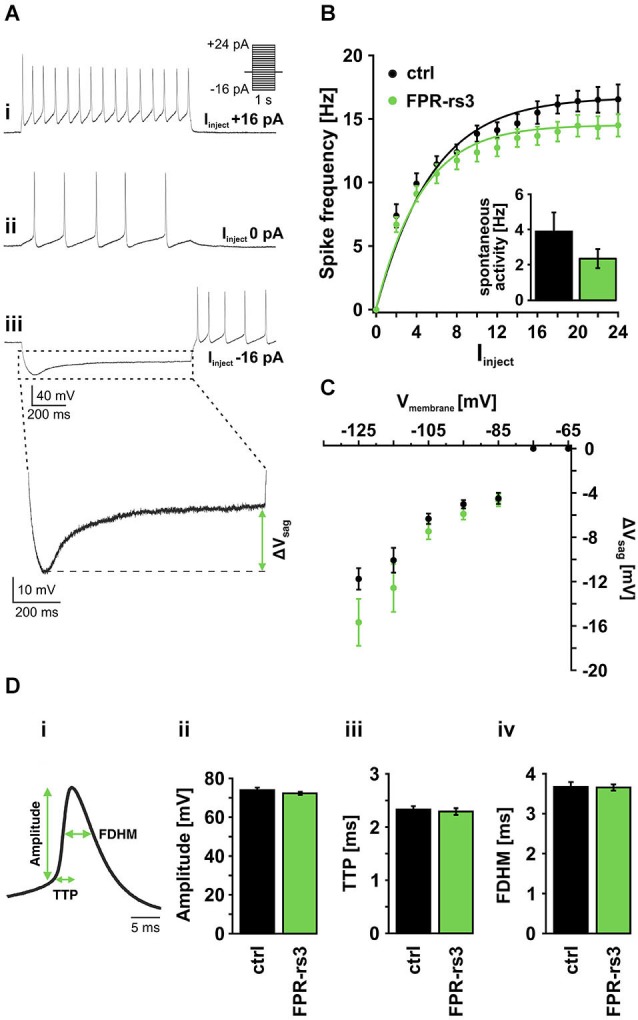
Active membrane properties of FPR-rs3+ VSNs. (A) Representative current clamp traces showing de- / hyperpolarization and trains of (rebound) action potentials generated upon stepwise current injection. Note the spontaneous activity measured at 0 pA current injection (Aii). Injection of negative current produces a prominent voltage “sag” most likely mediated by activation of HCN channels (Aiii). (B) Firing frequency of control (n = 21) and FPR-rs3+ (n = 19) neurons as a function of the injected current (Iinject). The gradual increase in firing rate is comparable for control and FPR-rs3+ VSNs. Inset: Spontaneous spiking frequency at 0 pA current injection. Note that f-I curves have been “background-corrected” using these values. (C) Voltage “sag” (ΔVsag, n = 3–32) as a function of the peak membrane hyperpolarization (10 mV bins). ΔVsag values of control and FPR-rs3+ neurons show no statistical difference (p > 0.01, two-tailed Student’s t-test). (D) Average spike waveform illustrating analysis parameters (amplitude, time-to-peak (TTP), full duration at half-maximum (FDHM; Di). Amplitude analysis of the first action potential for each current injection step shows no difference between control and FPR-rs3+ cells (Dii). TTP analysis reveals values in the same range for both cell populations (Diii). Spike width (FDHM) is not significantly different between control and FPR-rs3+ VSNs (Div). Data are mean ± SEM.